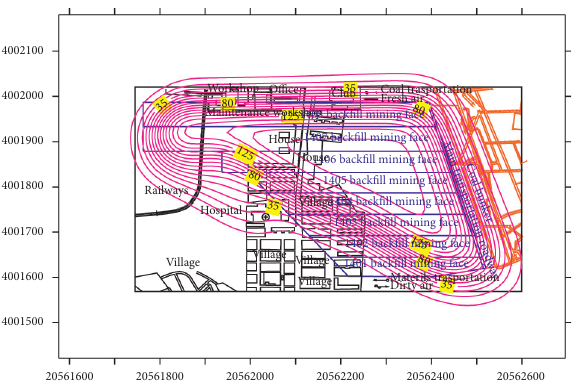
Figure 9: Contour map of surface subsidence in